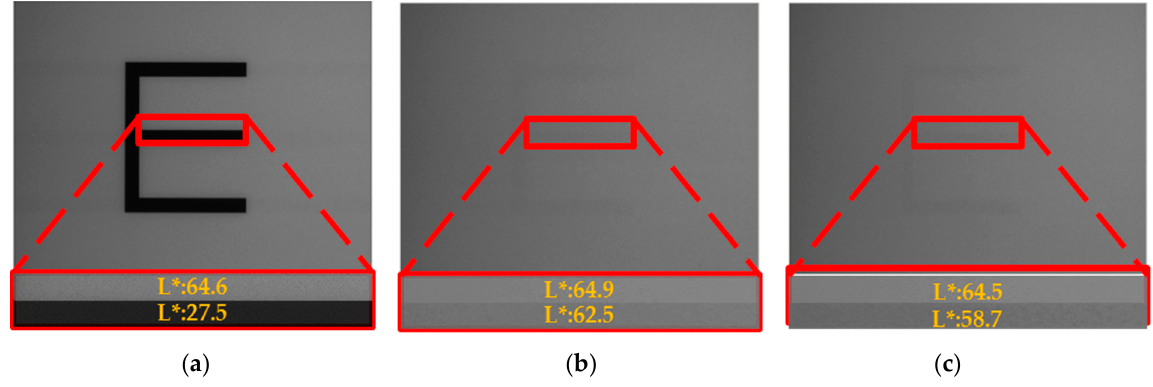
Figure 14. Visibility of the ghost image comparison between the proposed driving waveform and the conventional driving waveform. ( a ) Original image. ( b ) Driving effects of the proposed driving waveform. ( c ) Driving effects of the conventional waveform.